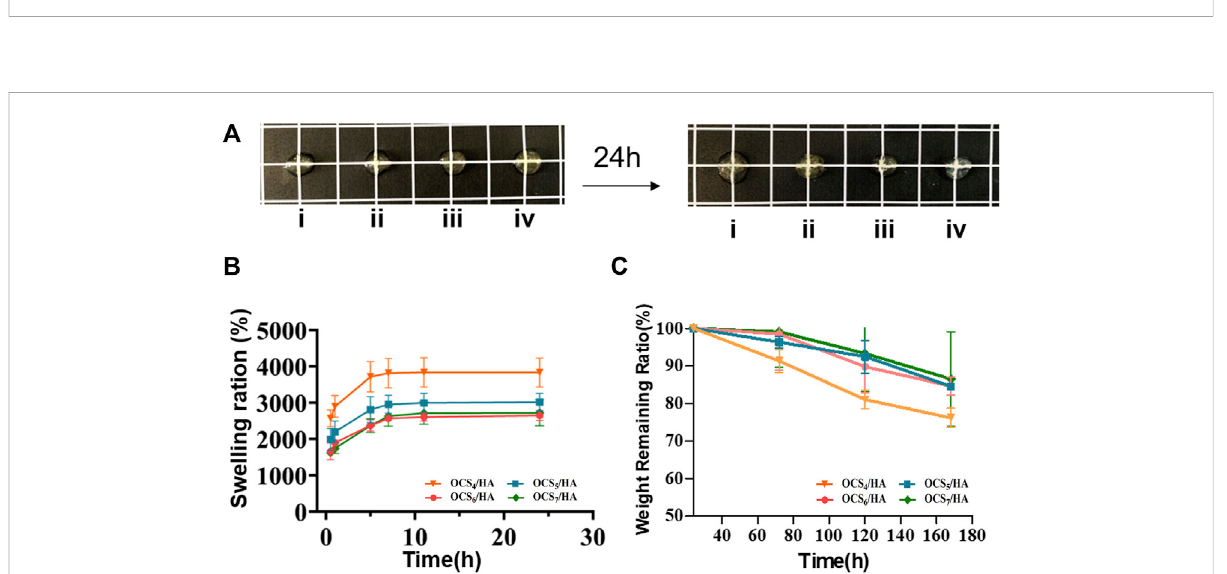
FIGURE 3 Swelling and degradation properties of the OCS/HA hydrogels with different OCS concentrations. (A) Photographic illustration of the OCS/HA hydrogels before and after reaching swelling equilibrium in a phosphate-buffered saline (PBS) buffer after 24 h: (i) OCS 4 /HA, (ii) OCS 5 /HA, (iii) OCS 6 / HA, and (iv) OCS 7 /HA. The square grid is 1 × 1 cm. (B) Swelling pro fi les of OCS/HA hydrogels over 24 h in PBS at 37 ° C. (C) Degradation ratio of the OCS/HA hydrogel in PBS at 37 ° C for 7 days in vitro